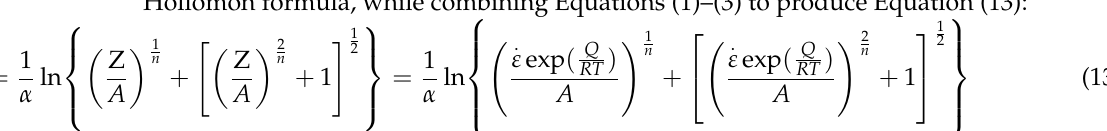
experimental predicted(b) Strain rate=0.1 s –1